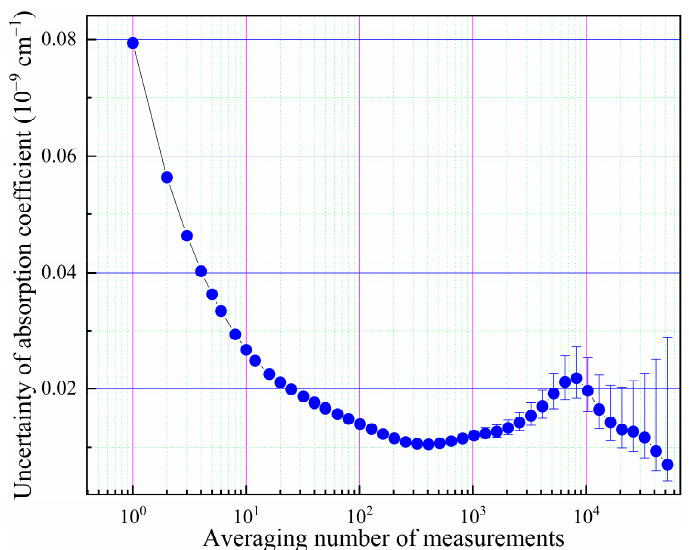
Figure 8. Allan variance analysis of the noise-equivalent absorption coefficient of the empty cavity as a function of the number of ringdown measurements, together with indications of 95% confidence intervals. The data rate is 9 measurements per second.